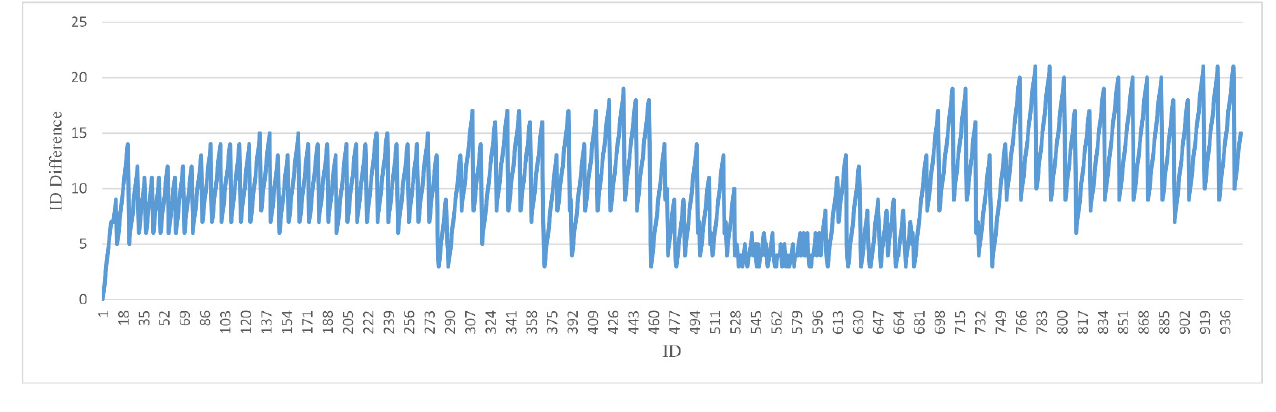
Table 5. Comparison of Dyna-SLAM and SOLO-SLAM processing times.